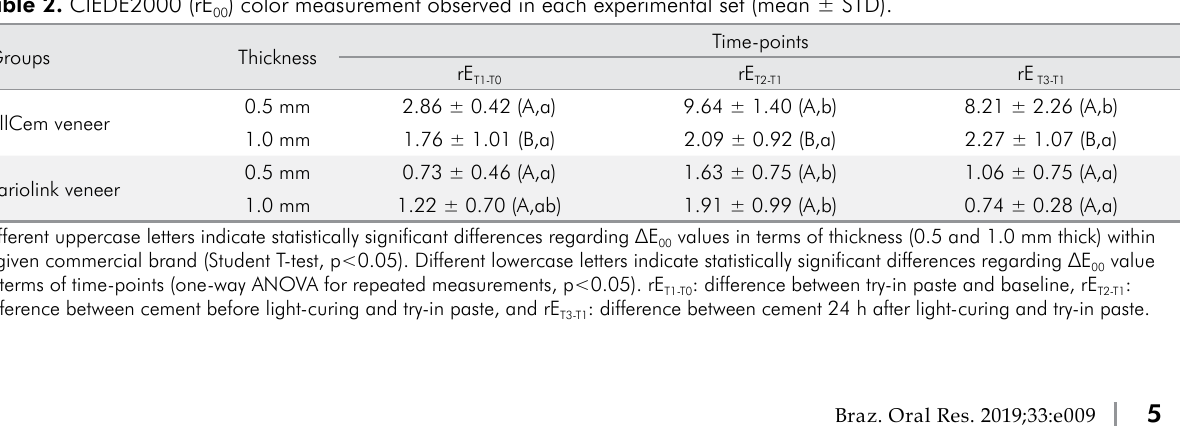
Table 2. CIEDE2000 (rE